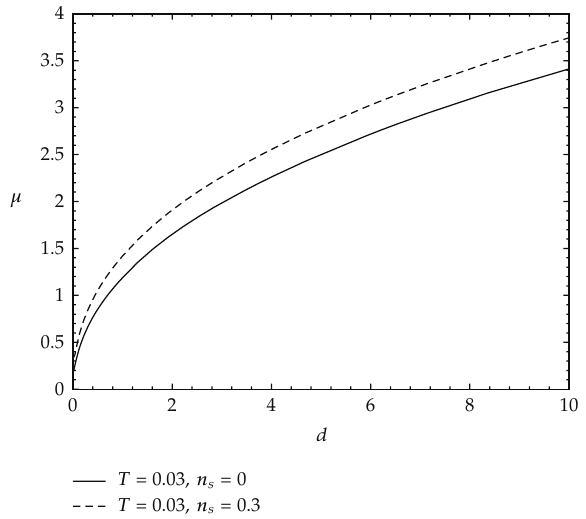
T = 0 . 03 , n s = 0 . Figure 8: The baryon chemical potential versus number density of the multiquark phase at T (cid:8) 0 . 03. relation can be well approximated by the power law with μ ∼ d for small density and μ ∼ d 2 / 5 for large density. The di ff erence indicates that the behaviour of multiquark quasiparticles is more like fermions as a consequence of the DBI action (cid:6) 48 (cid:7)